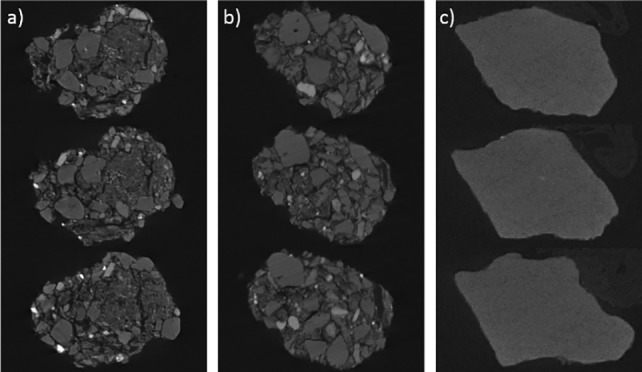
μCT slices taken from a) a pre-blast landscape soil aggregate; b) a pre-blast native soil aggregate; and c) a pre-blast Spearwood sand grain. All aggregates measured 1–2 mm in diameter. Source: Holly Yu, Curtin University/University of Dundee.